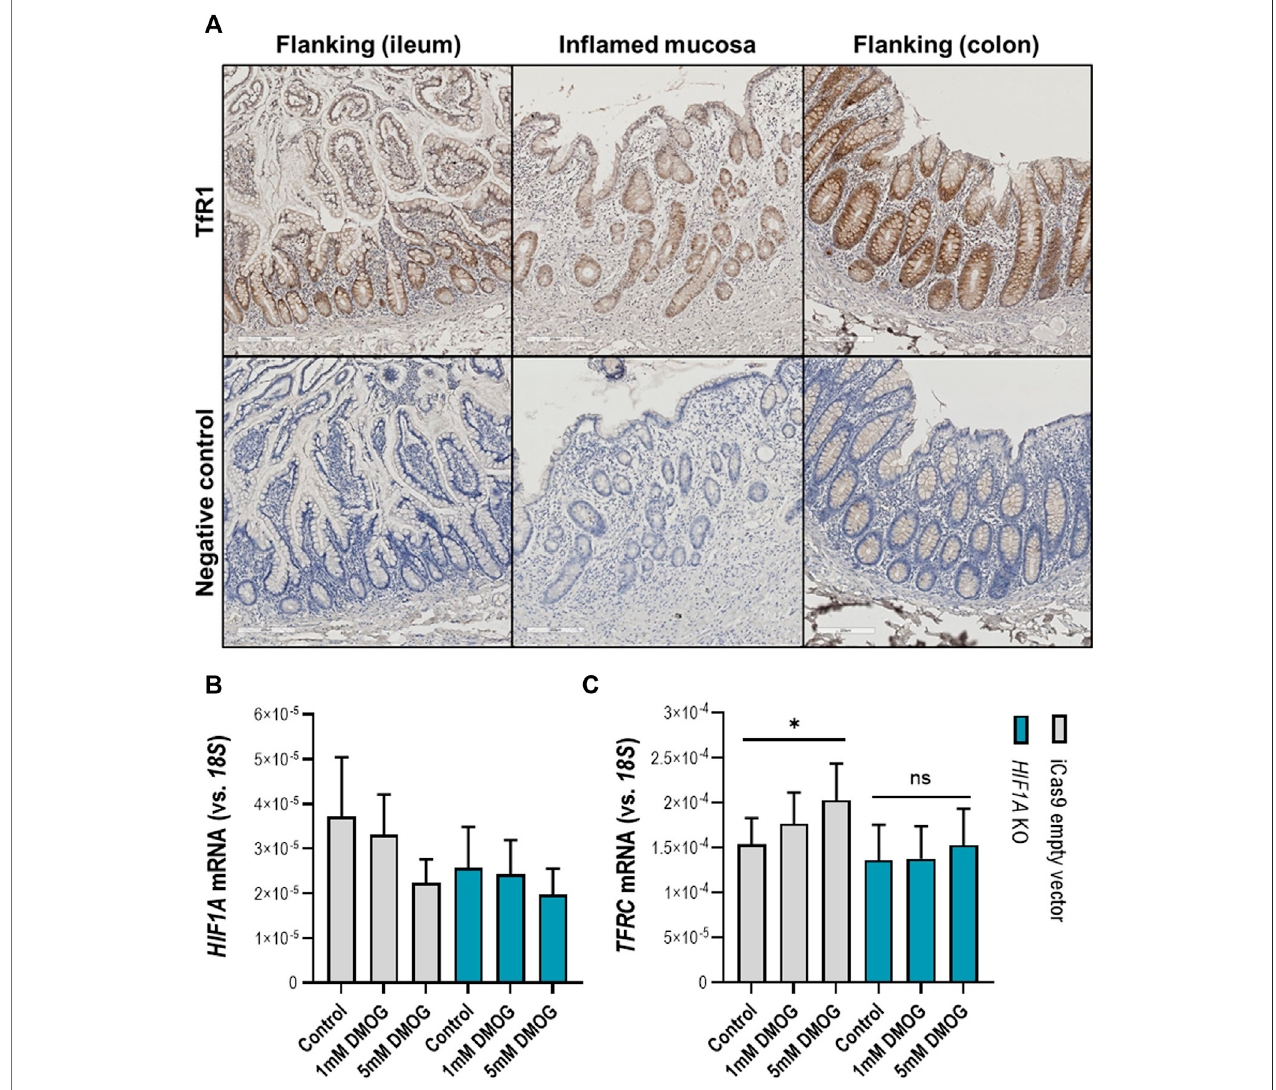
FIGURE 6 | (A – C) TFRC gene expression in human intestinal epithelial cells. (A) Transferrin receptor protein-1 (TfR1) immunohistochemistry staining in in fl amed (ileocecal) and fl anking regions of the human intestinal mucosa shows enrichment of TfR1 protein levels in the epithelial layer. Respective negative control staining is presented in thepanel below. Control and stable HIF1A -null Caco-2 cells treated with DMOG in two concentrationsand the effect on expression levels of (B) HIF1A and (C) TFRC . All data are presented as mean ± SEM. DMOG, Dimethyloxallyl Glycine. All the conditions were performed in duplicate to a N = 3; * p < 0.05; ns, not signi fi